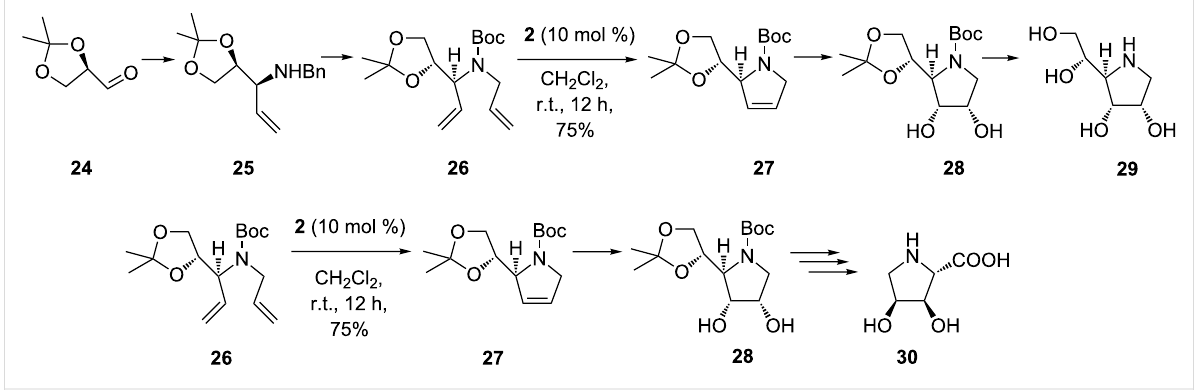
Scheme 5: Synthesis of 1,4-dideoxy-1,4-imino-D-allitol ( 29 ) and formal synthesis of (2 S ,3 R ,4 S )-3,4-dihydroxyproline ( 30 ).